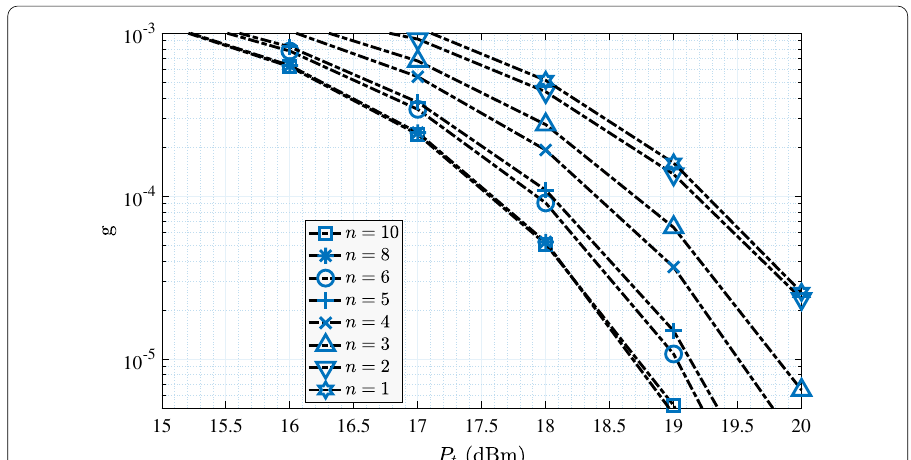
Fig. 4 Average BLER versus p t for different numbers of sub-intervals n . The parameters for the AE are set as follows: M = 16 , L =